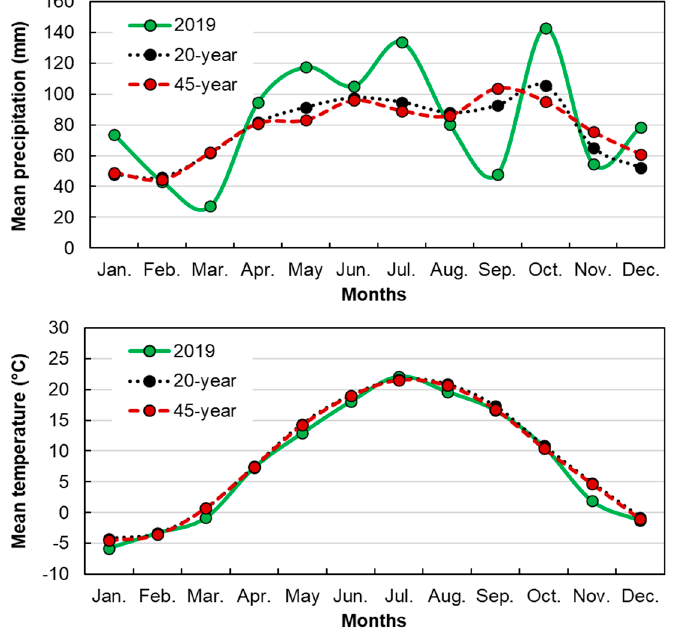
Figure 1. Mean precipitation and temperature during 2019 corn growing season along with 20-year and 45-year average. Weather data retrieved from the station at the Musgrave Research Farm in Aurora, New York from